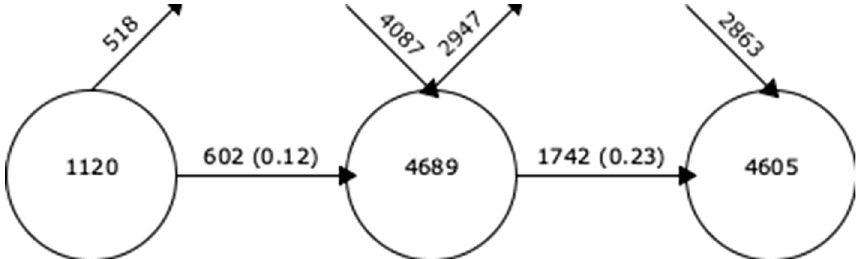
Fig. 7 Overlay graph of